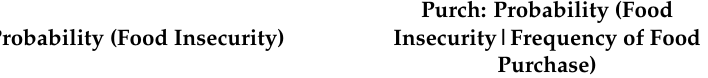
Table 3. Bivariate partial observability model on food insecurity and frequency of food